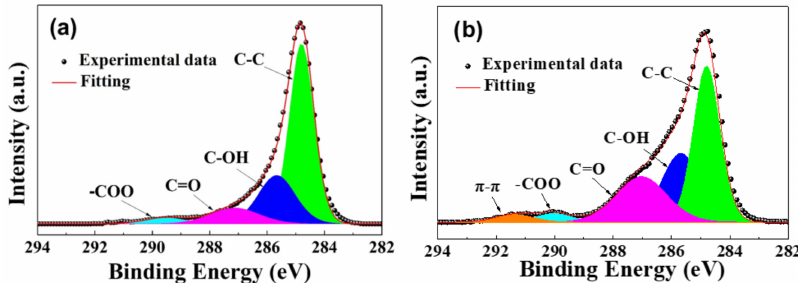
Figure 4. XPS spectra in the C 1 s region of ( a ) G and ( b ) PSS-G.